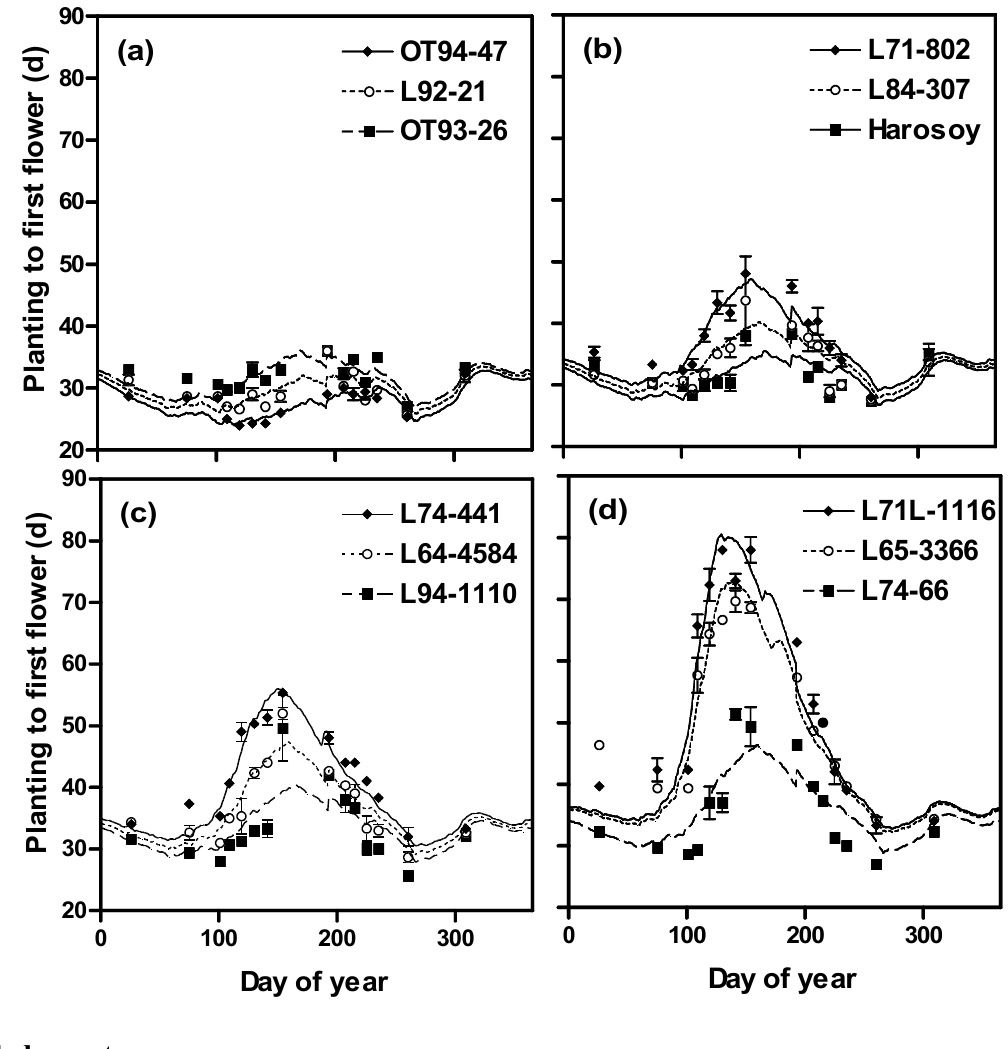
Figure 11. Days from planting to first flower versus the day of year when soybeans were planted based on the multiplicative model (lines) and observed values (symbols) for 12 soybean isolines varying from ( a ) least to ( d ) greatest